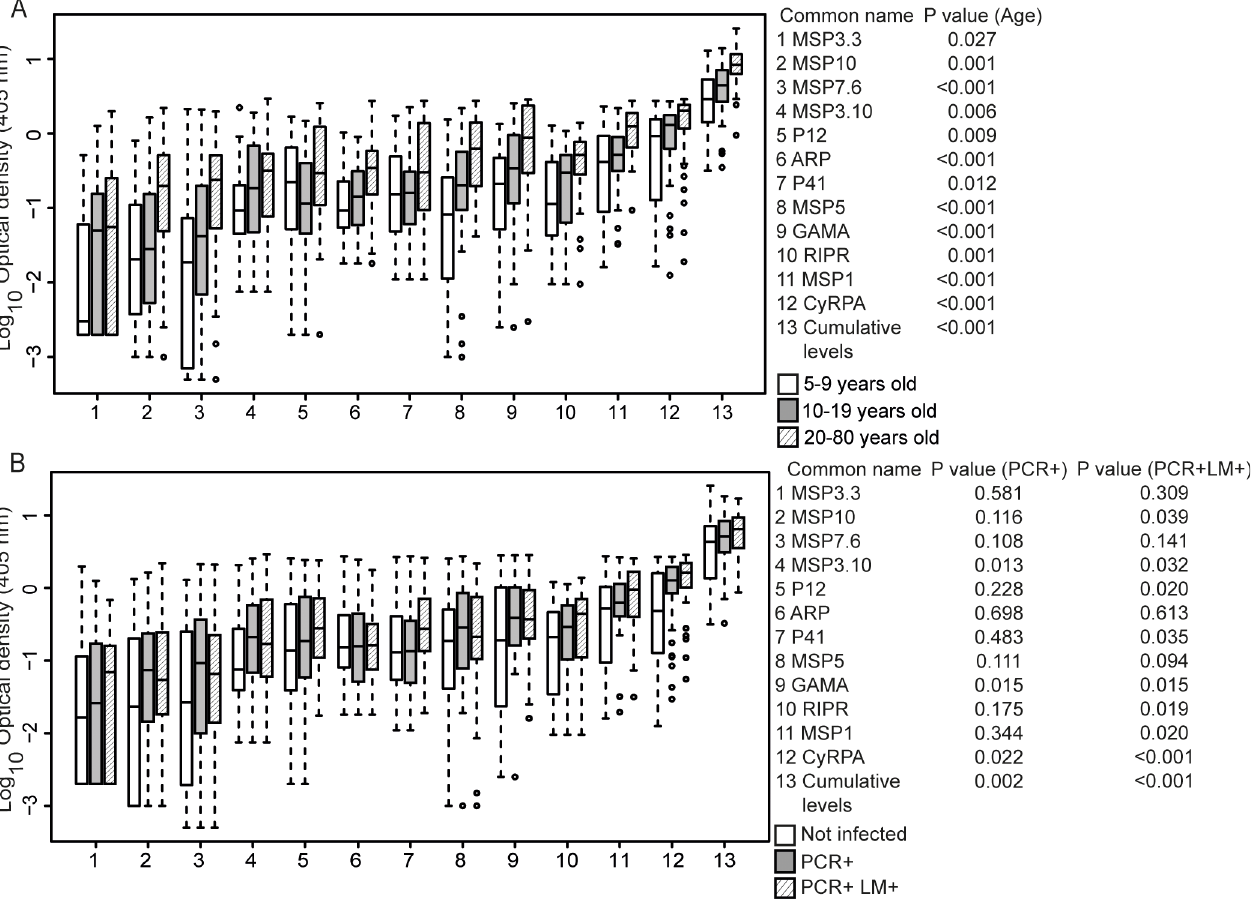
Fig 3. Magnitude of IgG levels to 12 P . vivax merozoite proteins in Solomon Islanders. Boxplots show median optical density (horizontal bar), interquartile range (boxes), range (whiskers), and outliers (open circles). (A) shows data according to age group (5 – 9 years, n = 48, clear boxes; 10 – 19 years, n = 48, grey boxes; 20 – 80 years, n = 48, striped boxes). (B) shows data according to P . vivax infection status (Not infected, n = 48, clear boxes; PCR+, n = 48, grey boxes; PCR+ LM+, n = 48, striped boxes). P values are from ANOVA and were deemed significant if <